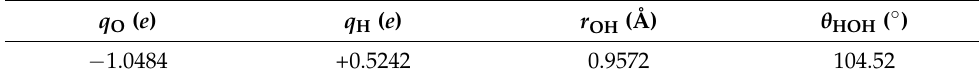
Table 1. Parameters of TIP4P model [35].